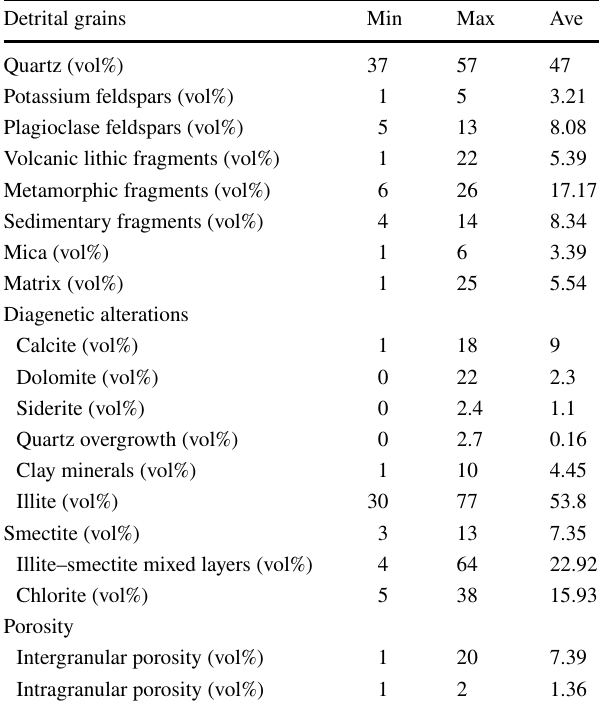
gram of sandstone classification. Three end members on the classifi- cation triangle chart are quart, feldspar and rock debris. c Lithological compositions triangular diagram. Three end members on the classifi- cation triangle chart are grains and pores, matrix and